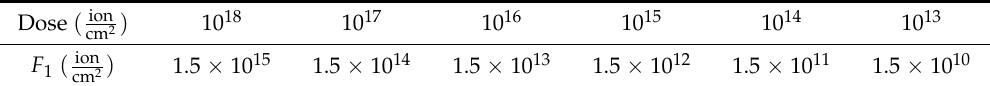
Table 2. Estimated values of parameter F 1 as a function of irradiation